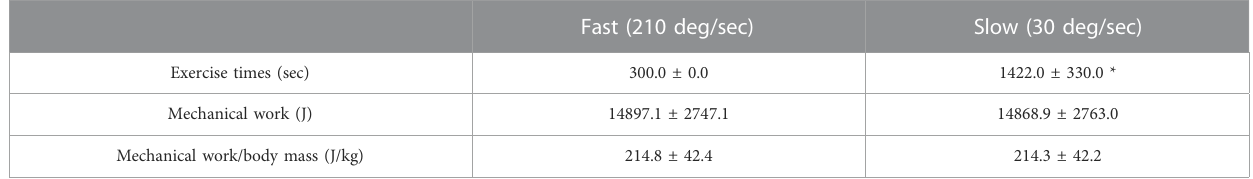
TABLE1Meansvalues(SD)duringeccentriccyclingfortheFastandSlow,exercisetime,energyexpenditure,totalmechanicalwork,andpeaktorqueat210 ° /s,and 30 ° /s. *Denotes a signi fi cant ( p < 0.05) difference between Fast and